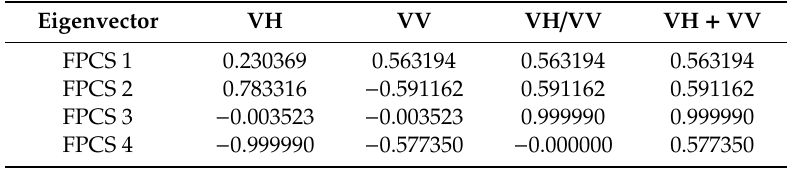
Table 1. Eigenvector matrix of copolarized and cross-polarized backscattering for Sentinel-1 Feature- oriented Principal Components Selection (FPCS) images. Eigenvector